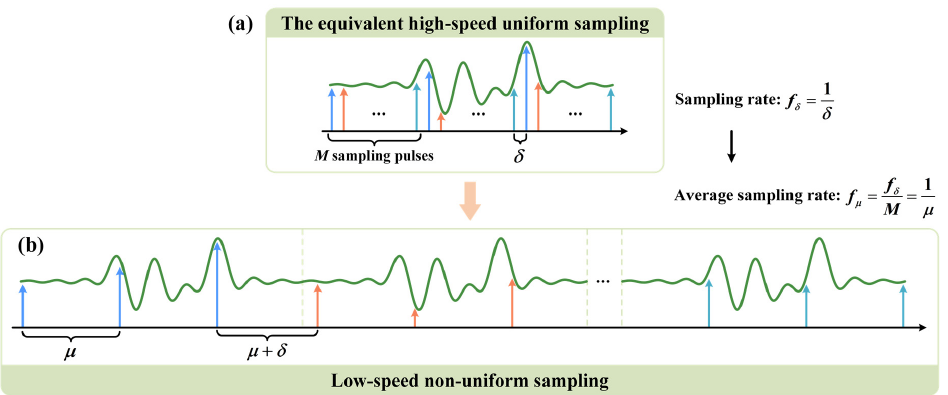
Figure 2. Schematic diagram of the proposed NPS strategy. ( a ) The equivalent high-speed uniform optical pulse train is divided into M groups of low-speed uniform optical pulse train. ( b ) Low-speed non-uniform optical pulse train generated by connecting the M groups of low-speed uniform optical pulse train in